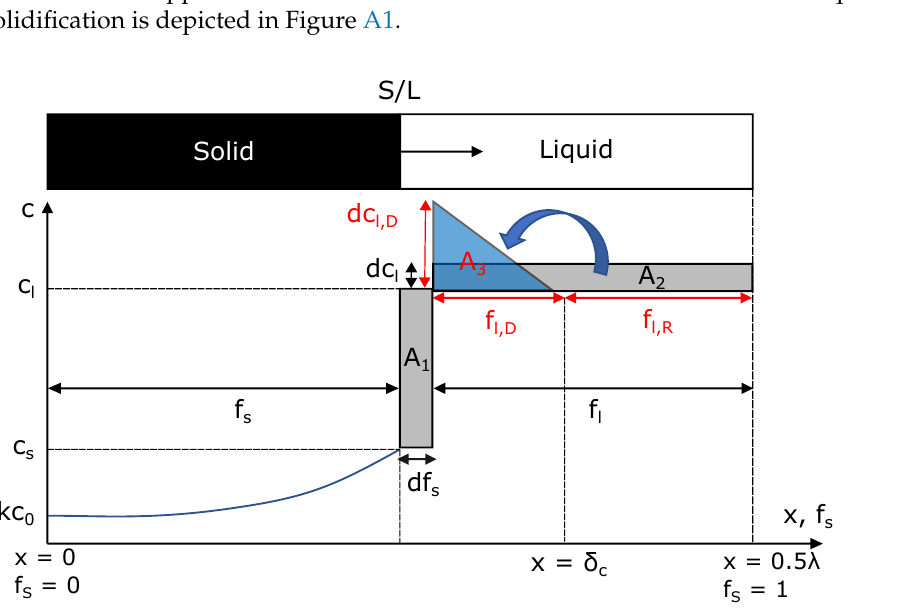
Figure A1. Mathematical approach of calculating the concentration distribution during solidification in the solid and liquid for the classical Scheil approach (areas A 1 and A 2 ) are considered as well as a new advanced approach for calculating a non-homogeneous distribution in the melt (additionally A 3 is considered). The concentration c is depicted in the solid ( c s ) and the liquid ( c l ) over the solid fraction f s at an arbitrary time during solidification. Equivalently to the solid fraction, the solidification distance x can be considered. The liquid fraction f l in the classical case and the split of this fraction into f l,D and f l,R for the advanced approach are